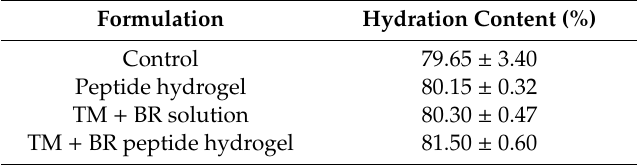
Table 3. Hydration content values of the corneas at the end of the ex vivo permeability study.